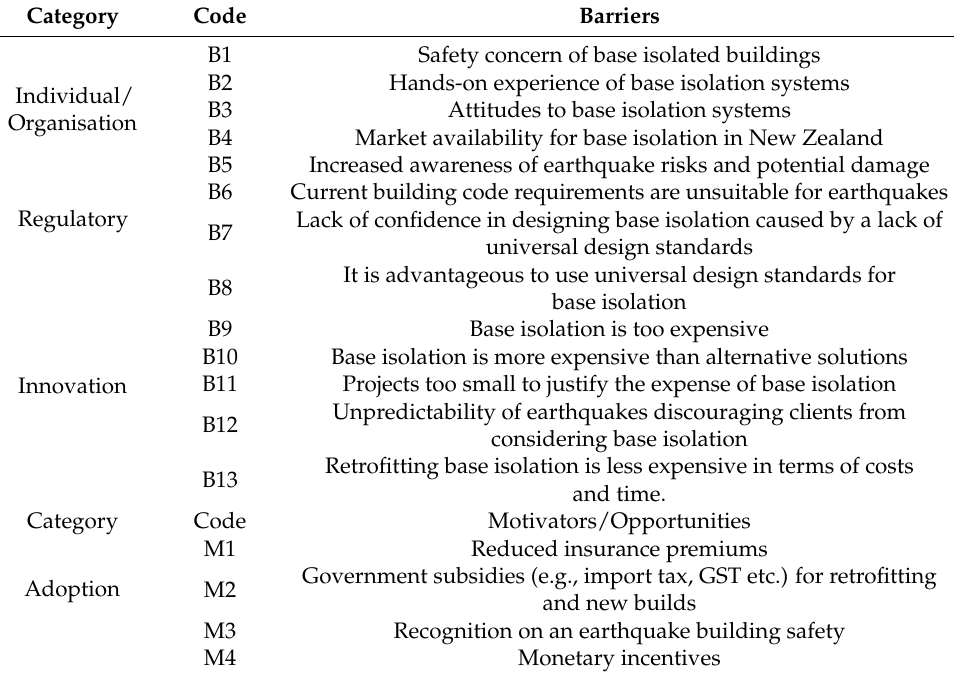
Table 3. Barriers and motivators for BIS.